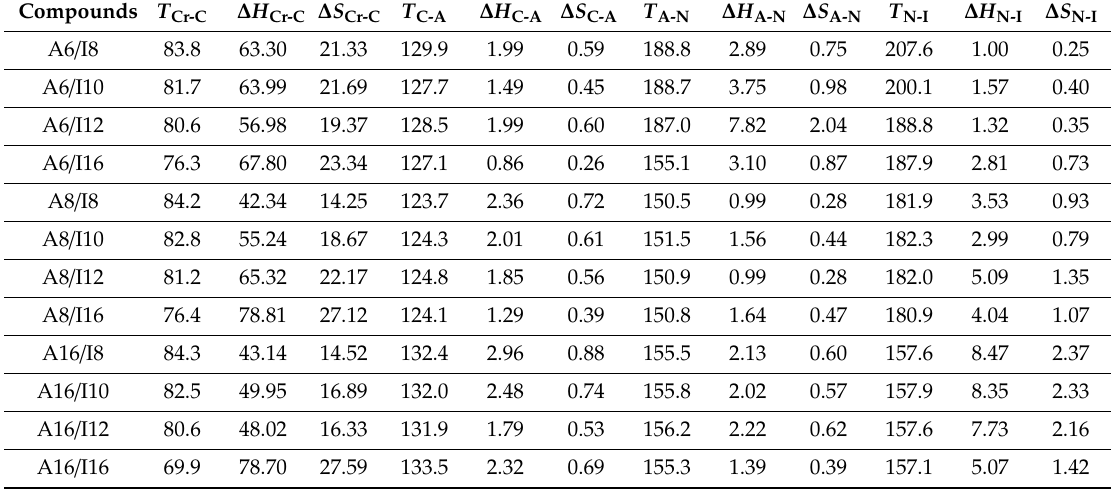
Table 1. Phase transition temperatures ( ◦ C), enthalpy of transitions (kJ / mol) and normalized transition entropy for the supramolecular complexes An / Im.